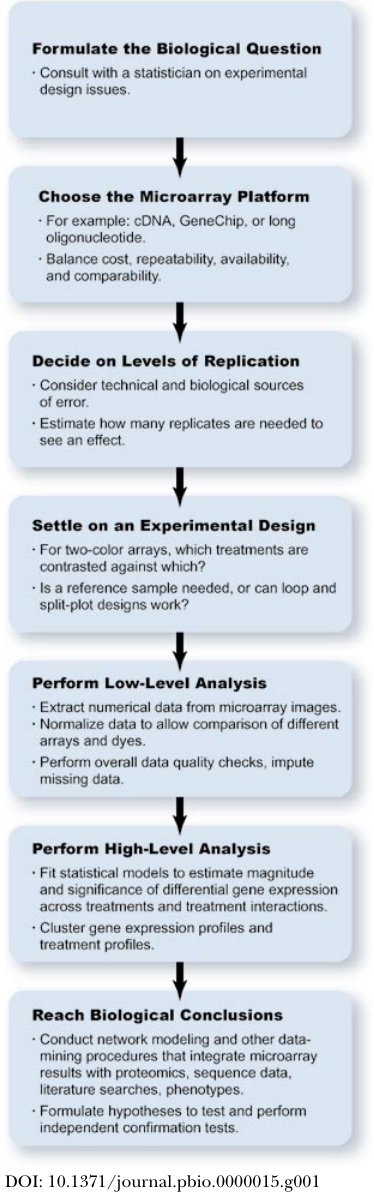
Figure 1. Flow Diagram of Gene Expression Primers provide a concise introduction into an important aspect of biology that is of broad and current interest.